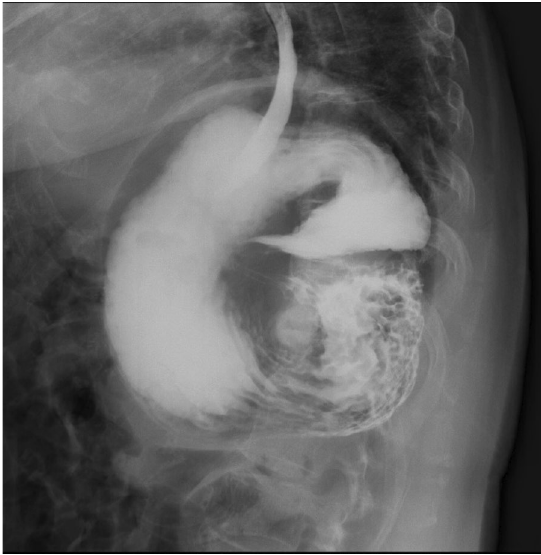
Fig. 3 Preoperative contrast studies were performed to confirm the presence of mesentero-axis dorsal 180-degree volvulus